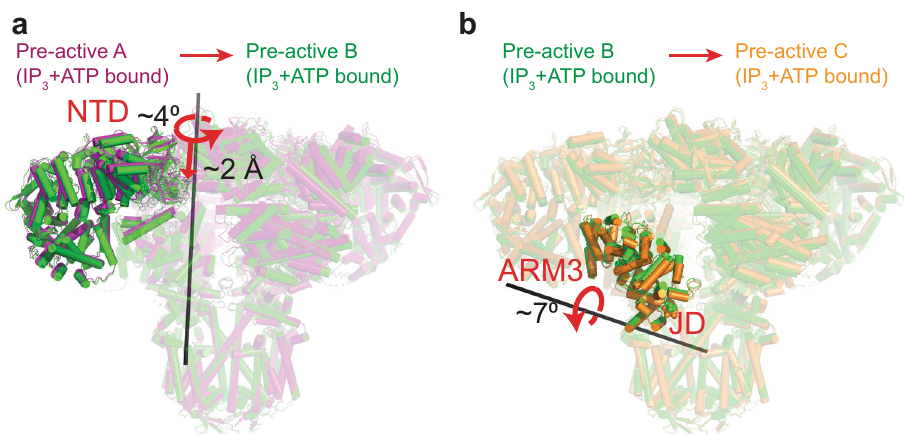
Fig. 2 Conformational changes in the pre-active states. a , b Ribbon representations of hIP 3 R structures superposed on the residues forming the selectivity fi lter and P-helix of the TMDs, emphasizing the conformational changes between the states indicated above. Domains with substantial conformational changes are shown in full colors only on one subunit, while the rest of the protein is transparent. Curved and straight red arrows indicate the rotation and translation of the domains with red labels relative to the rotation axis (black